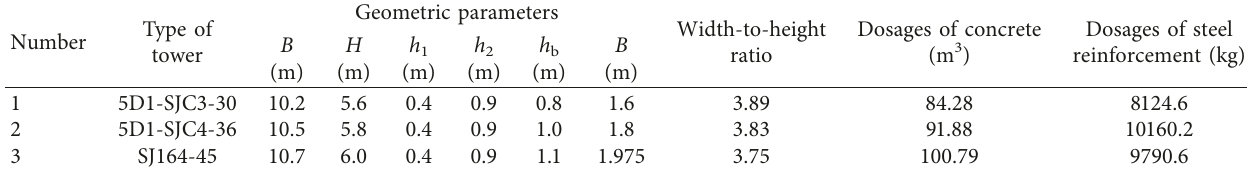
Figure 18: Drawing of the foundation designed by the suggested method. (a) Elevation of foundation. (b) Plan of foundation. Table 12: Design results by the suggested